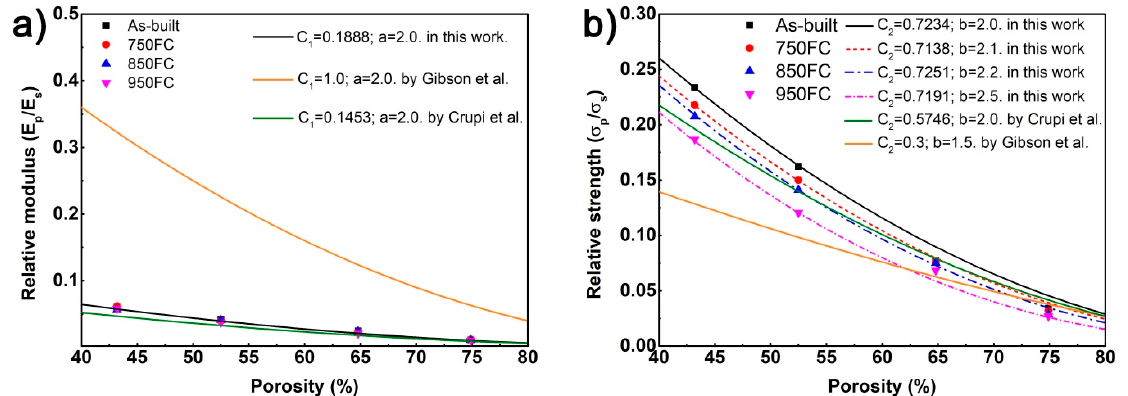
Figure 11. Relationship between the porosity of porous structure ( a ) and its elastic modulus and compressive strength ( b ).